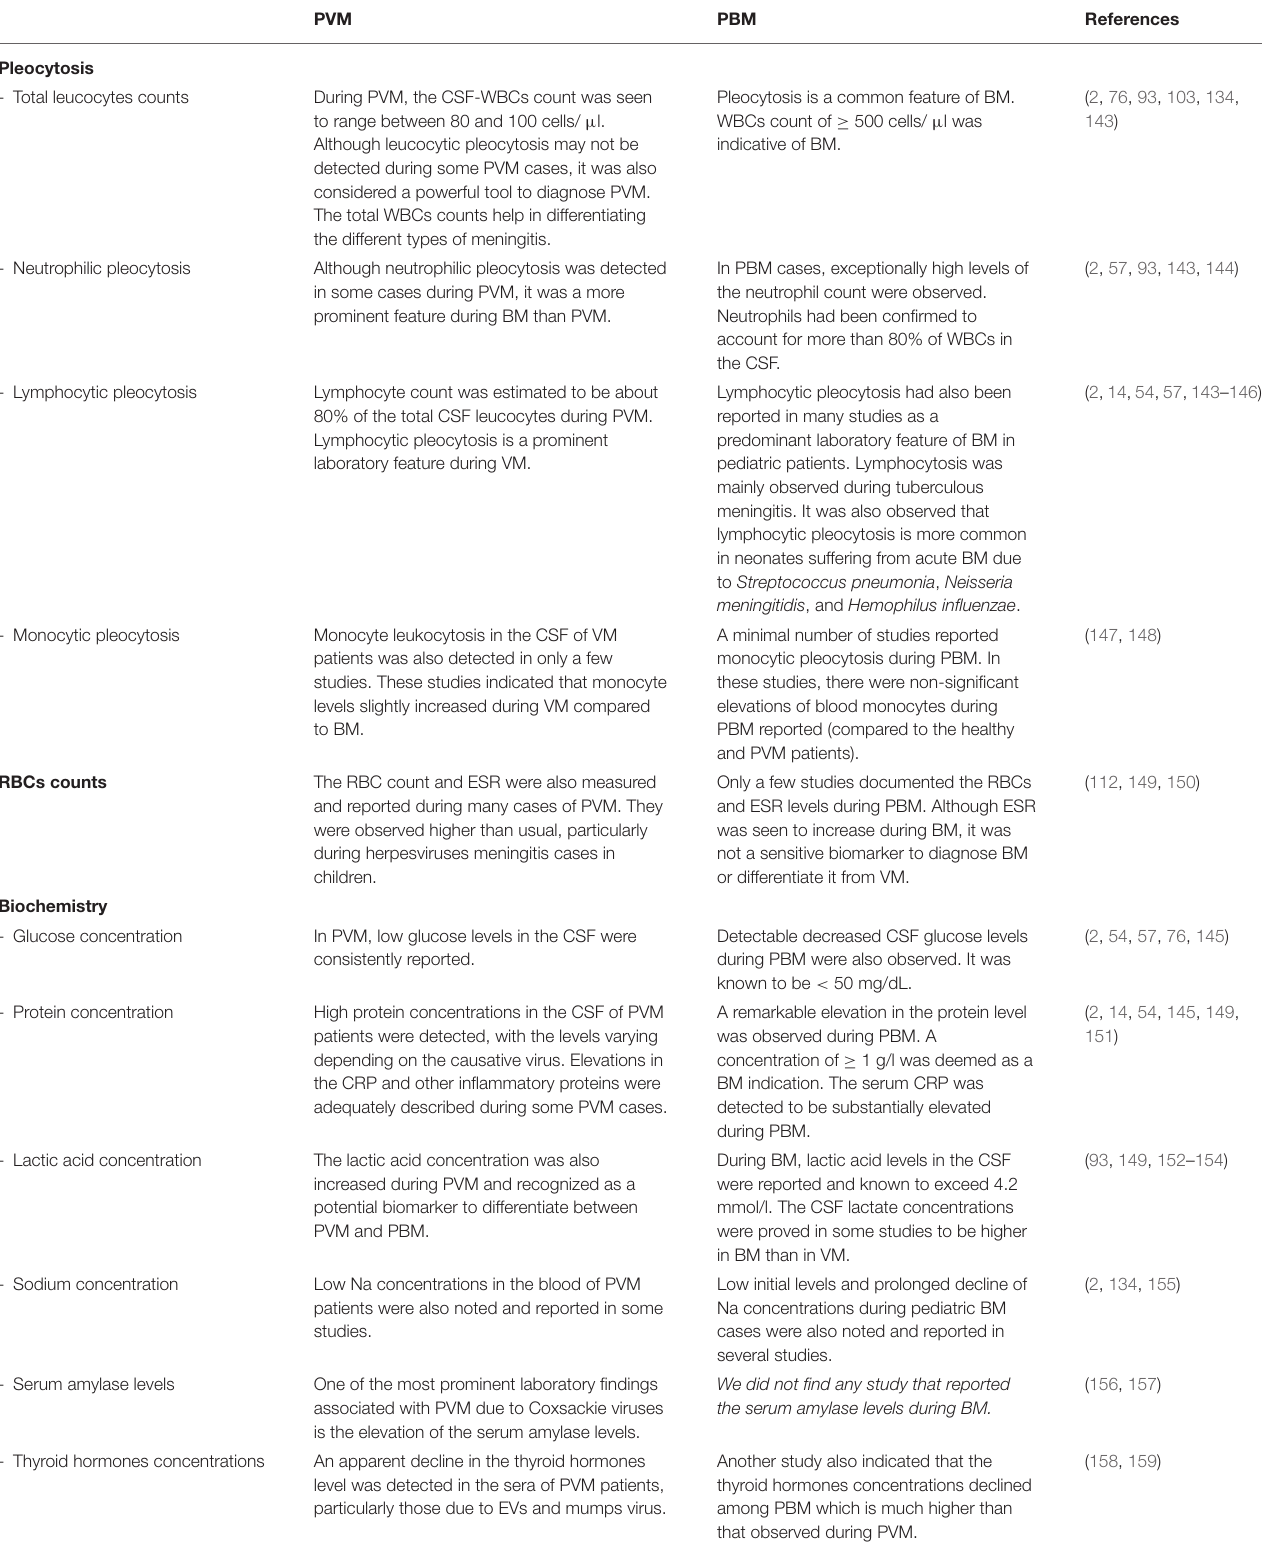
TABLE 2 | Cytology and biochemistry of plasma and cerebrospinal fluids of pediatric viral and bacterial